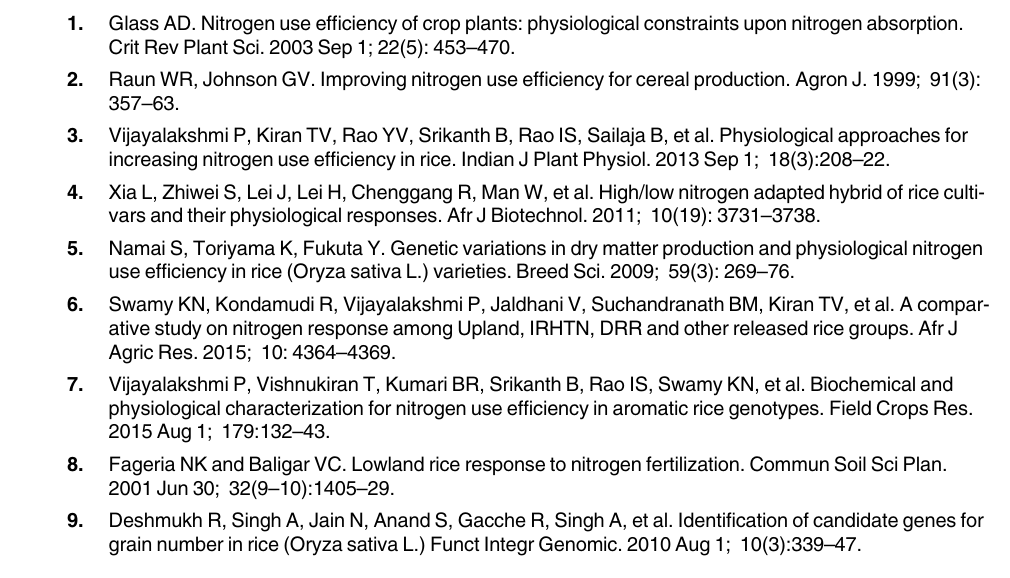
S2 Fig. Venn diagram showing unique and shared marker trait associations across under low and recommended nitrogen levels across wet and dry